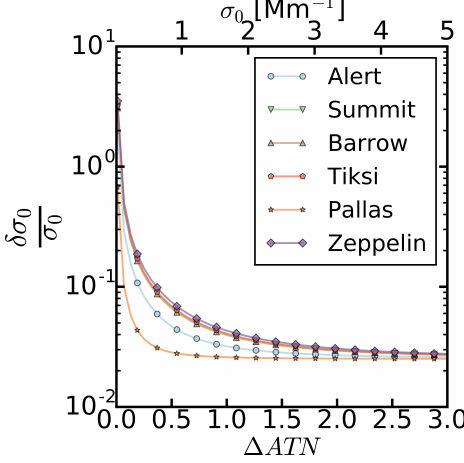
Figure 4. Relative uncertainty of attenuation coefficients as a func- tion of change in filter attenuation ( (cid:49) ATN); see Eq. (7). The up- per x scale was calculated using A = 0.5cm − 2 , Q = 5Lmin − 1 and (cid:49)t = 60min for